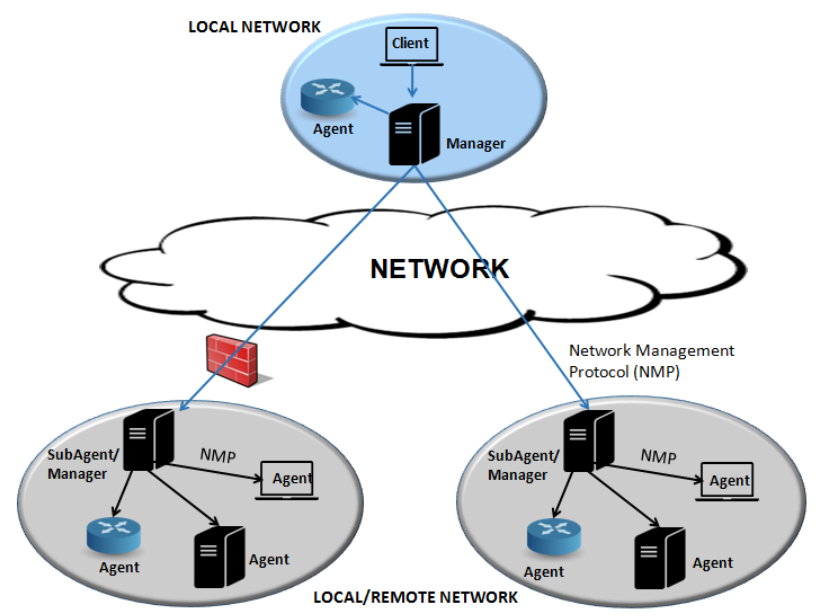
Figure 3. Components of network management systems.